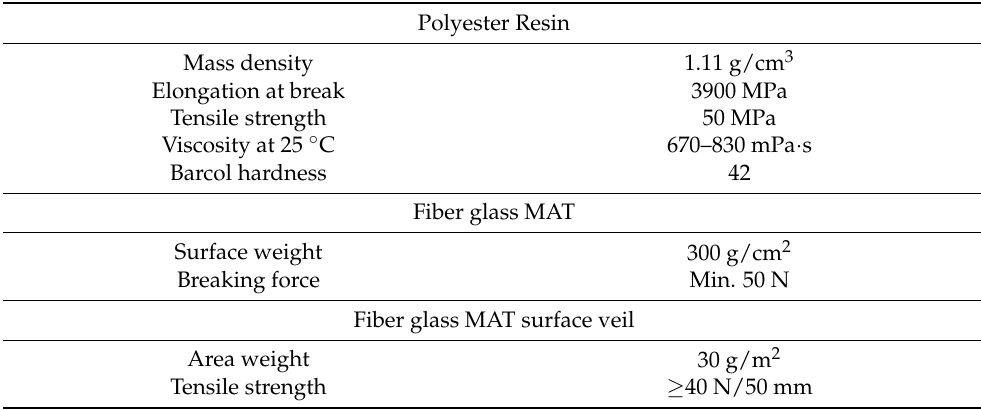
Table 1. Chemical and physical characteristics of resin and fiber glass.